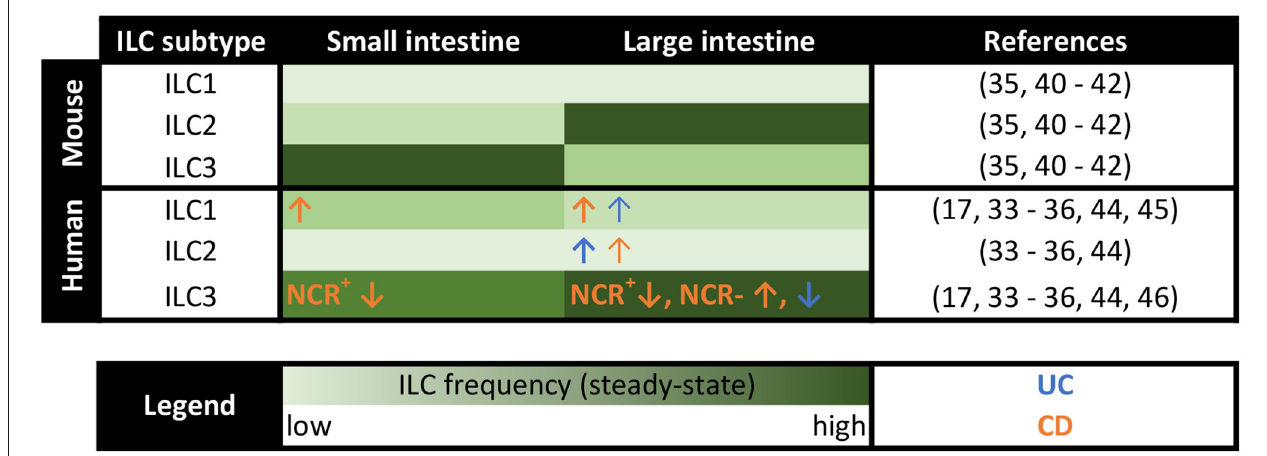
FIGURE 1 | Distribution of murine and human ILCs along the intestine in steady-state and IBD patients. Heatmap summarizing the distribution of the classical helper ILC subsets in the lamina propria of the small and large intestine in both mice and humans. The frequency of ILCs is color-coded with the light green color indicating low frequencies and the dark green color representing high ILC percentages. Changes in local ILC frequencies in patients with ulcerative colitis (UC) and Crohn’s disease (CD) are indicated by blue and orange arrows,